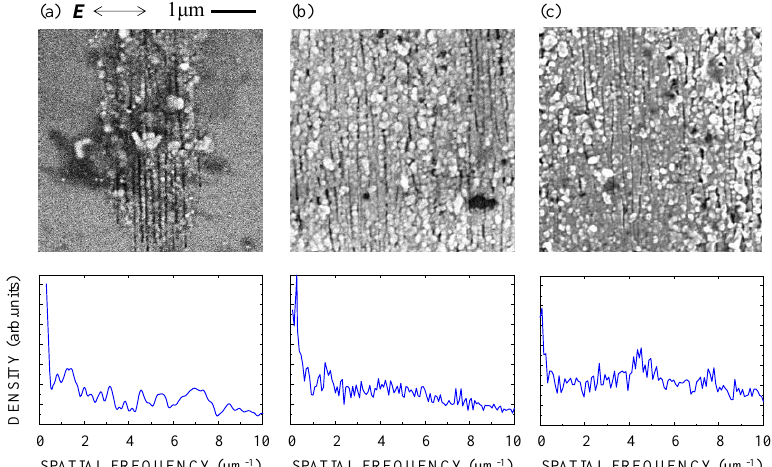
Figure 5. SEM image (top) and Fourier spectrum (bottom) of the silicon suboxide films irradiated with ( a ) N = 250, ( b ) N = 500, and ( c ) N = 1000 fs laser pulses at F = 700 mJ/cm 2 . E denotes the direction of the polarization.